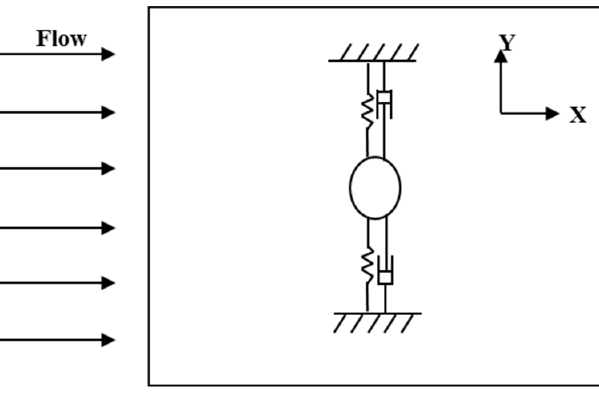
Figure 8. Physical model of the vortex-induced vibration of a single cylinder.